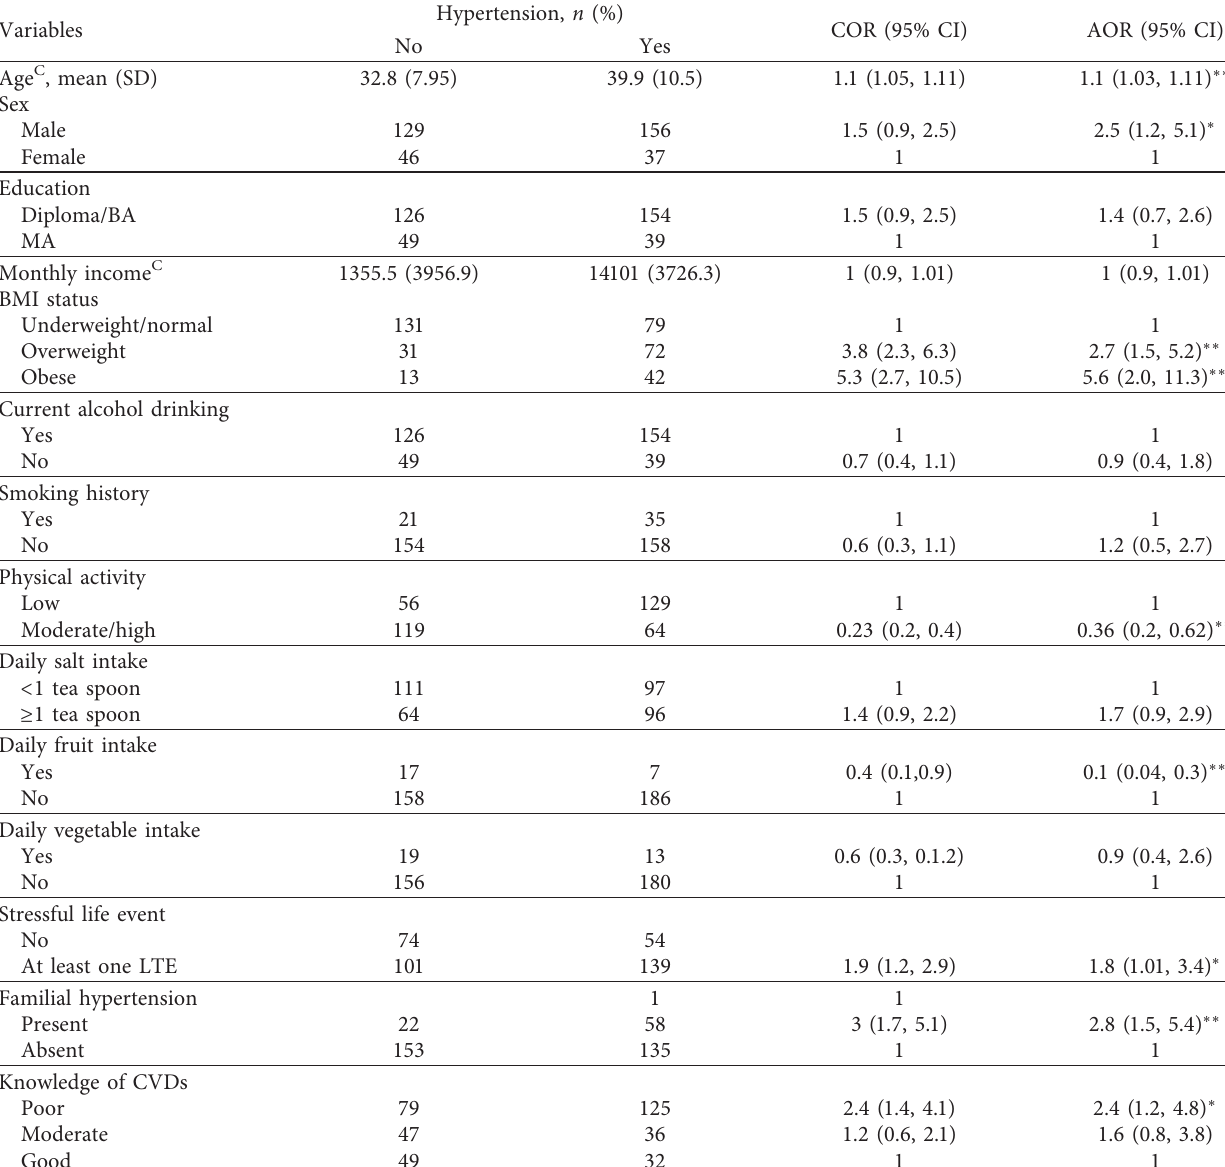
Table 4: Factors associated hypertension among bank employees in metropolitan cities of Amhara Regional State, Ethiopia, 2020 ( n � 368).